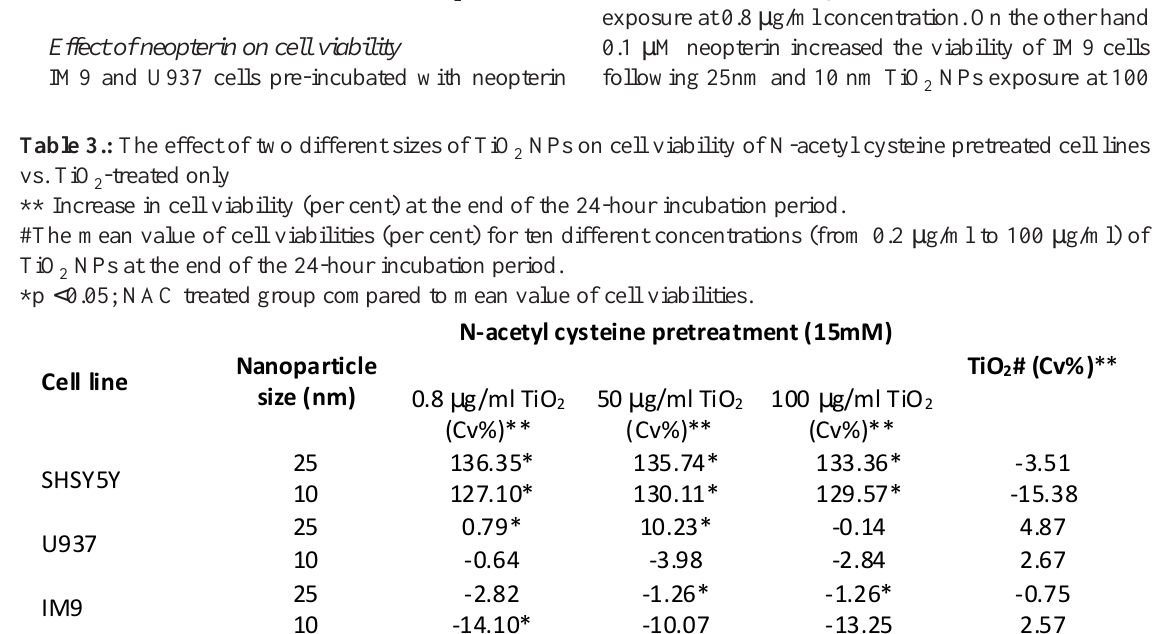
NPs on cell viability of N-acetyl cysteine pretreated cell lines 2